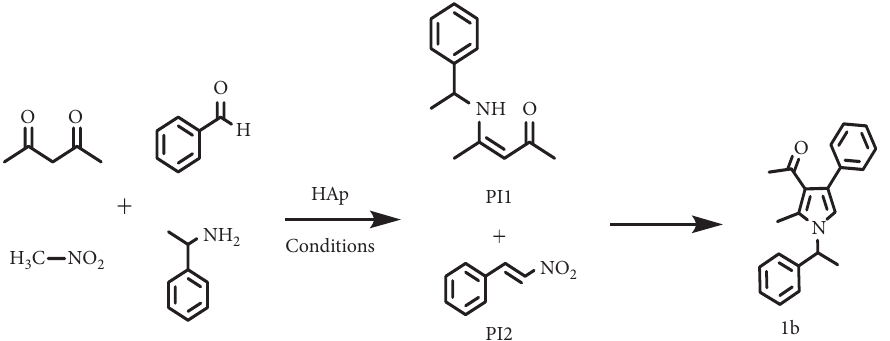
Scheme 3: Reaction of pyrrole